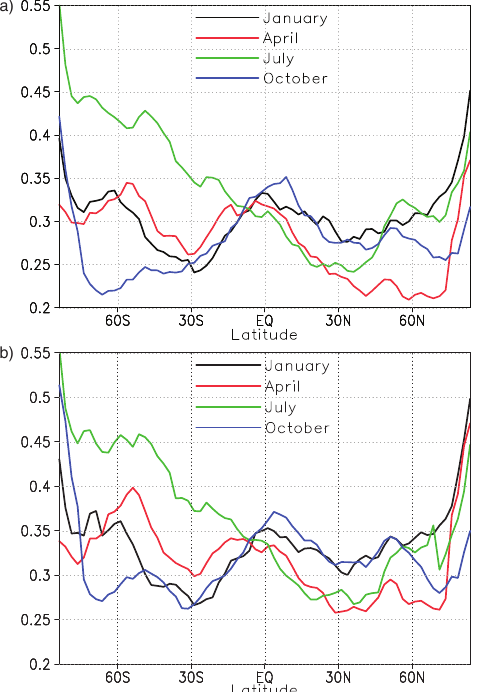
Figure 12. Latitudinal average over the entire period of the abso- lute value of the normalized difference of the mean next amplitude (a) and the next-but-one amplitude (b) for January, April, July, and